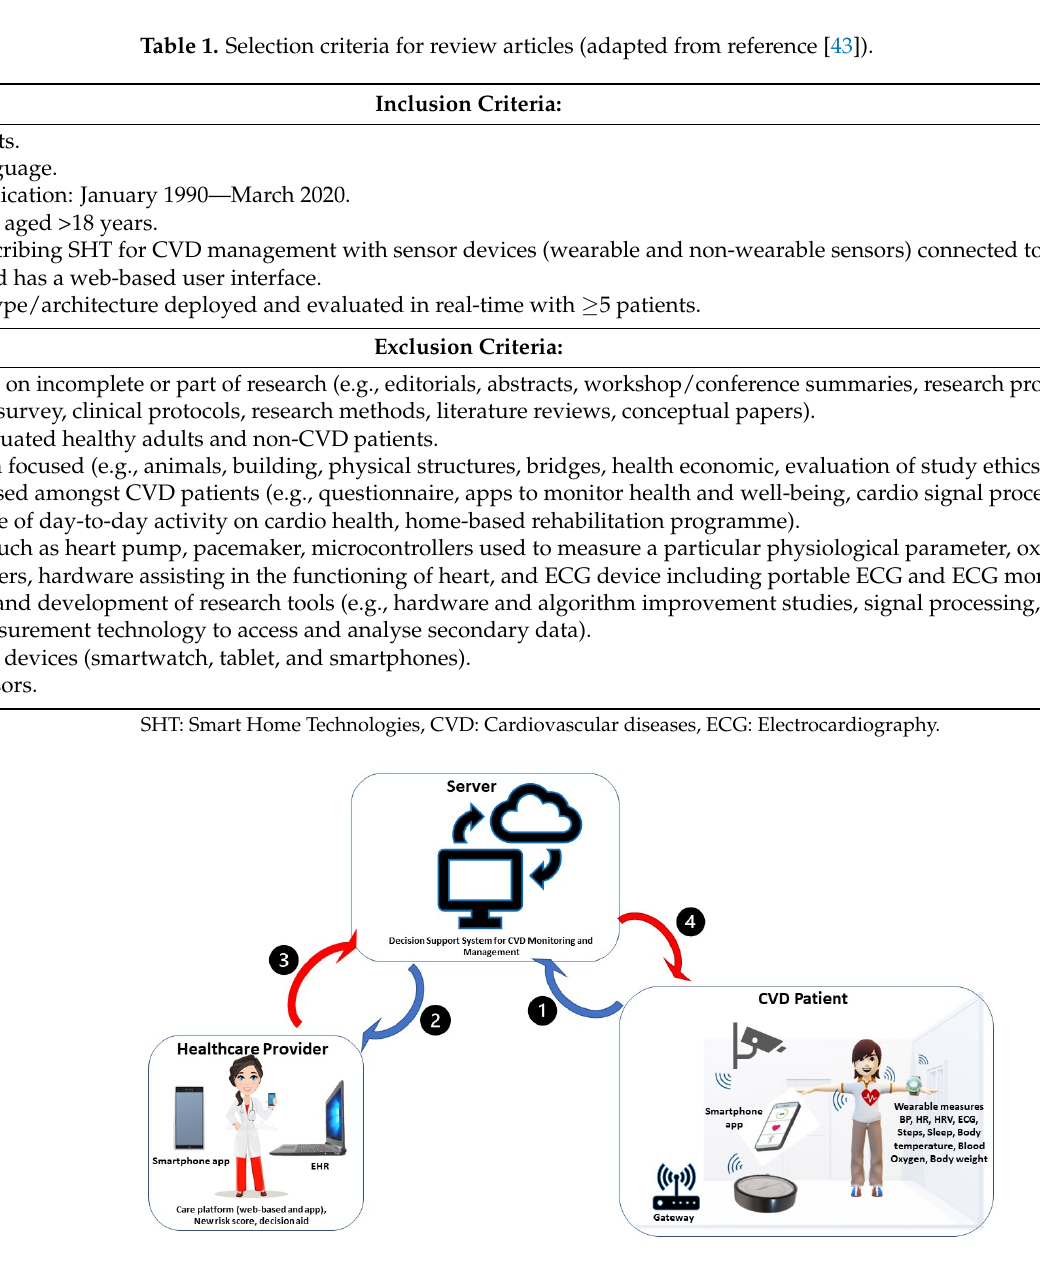
Figure 1. A smart home system for CVD and vital signs monitoring. (The arrows indicate the direc- tion of the communication/transfer. Arrow 1: Transfer of recordings from patient to server for pro- cessing, Arrow 2: Processed information transfer to healthcare providers for analysis and initiate necessary care and intervention, Arrow 3: Alerts and intervention initiated by the health care pro- vider, and Arrow 4: Patient receiving necessary notification, including alerts and intervention to upkeep their health and well-being.)